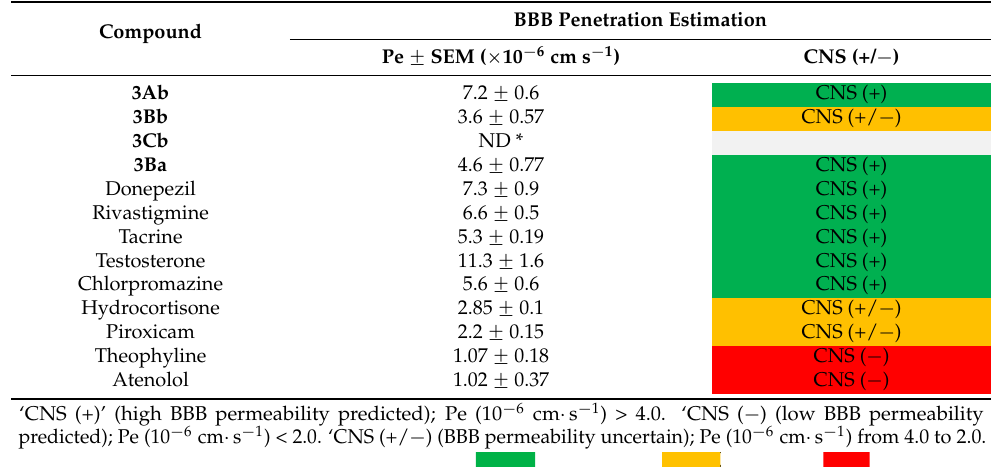
Table 3. Prediction of BBB penetration of drugs expressed as Pe ± SEM ( n = 6–8).